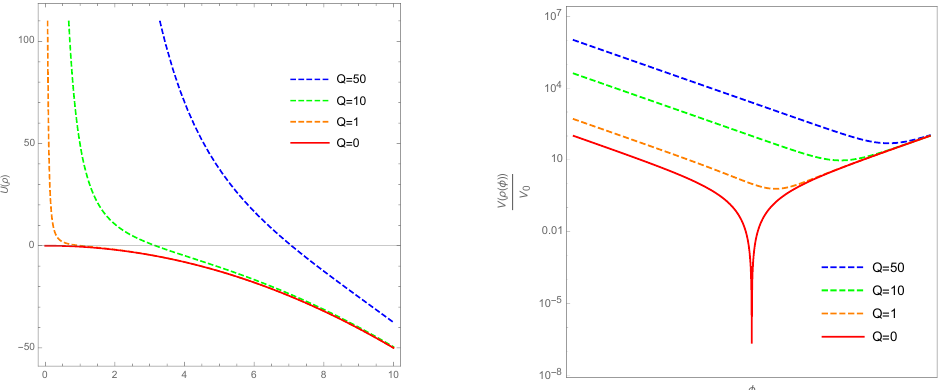
Figure 2. Equation (25) has the form of the equation of motion of a classical point particle with potential U ( ρ ) = − 1 m 2 ρ 2 + Q 2 . The potential is plotted for different values for Q while m and is kept fixed 2 2 ρ 2 ( left ). Solutions to Equation (25) (initial conditions are arbitrarily chosen) lead to a plot for the volume ( right ). The point in relational time where the minimum of solutions is reached corresponds to the bounce. The solution for Q = 0 does not exhibit a bounce since the volume vanishes when U ( ρ ) turns to zero. In the plots and in this caption the label j is